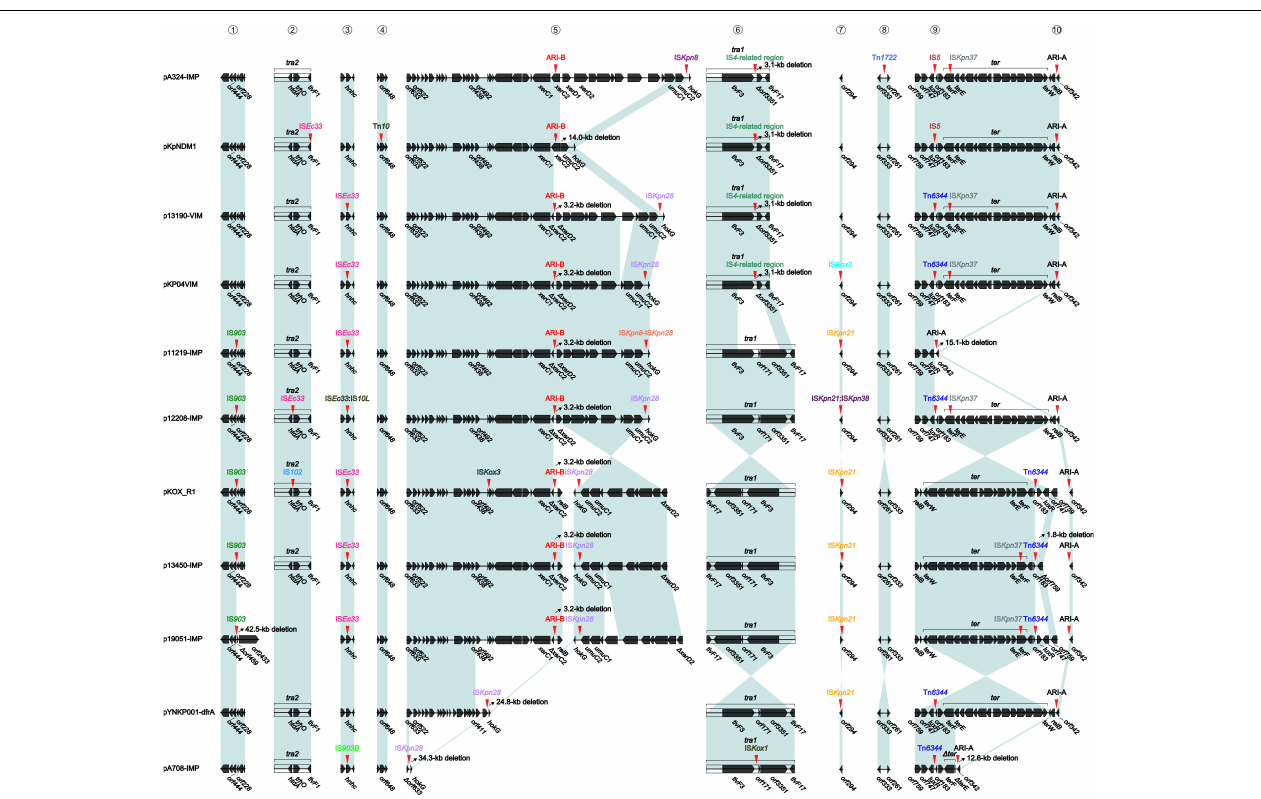
FIGURE 2 | Sites of insertion of accessory modules. Genes are denoted by arrows. Genes, mobile elements and other features are colored based on function classification. Shading denotes regions of homology ( > 95% nucleotide